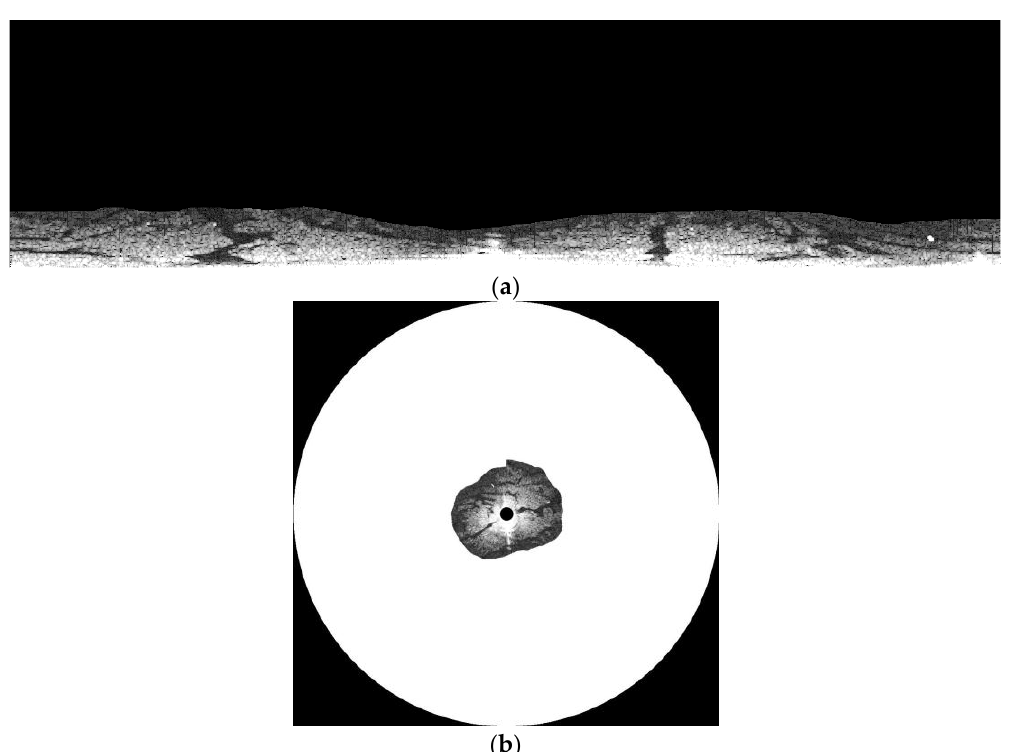
Figure 9. Selected region of radar image for oil spills detection: ( a ) selected region in the Cartesian coordinate system; and ( b ) the selected region in the polar coordinate system.